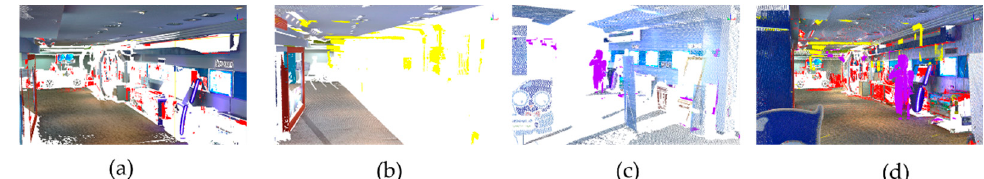
Figure 15. Description of the noise detection result of each single sensor data and merged result. ( a – c ) are the noise detection results of sensors 1, 2, and 3, respectively. ( d ) is the noise detection result using multiple sensor data that are a combined result of ( a – c ).